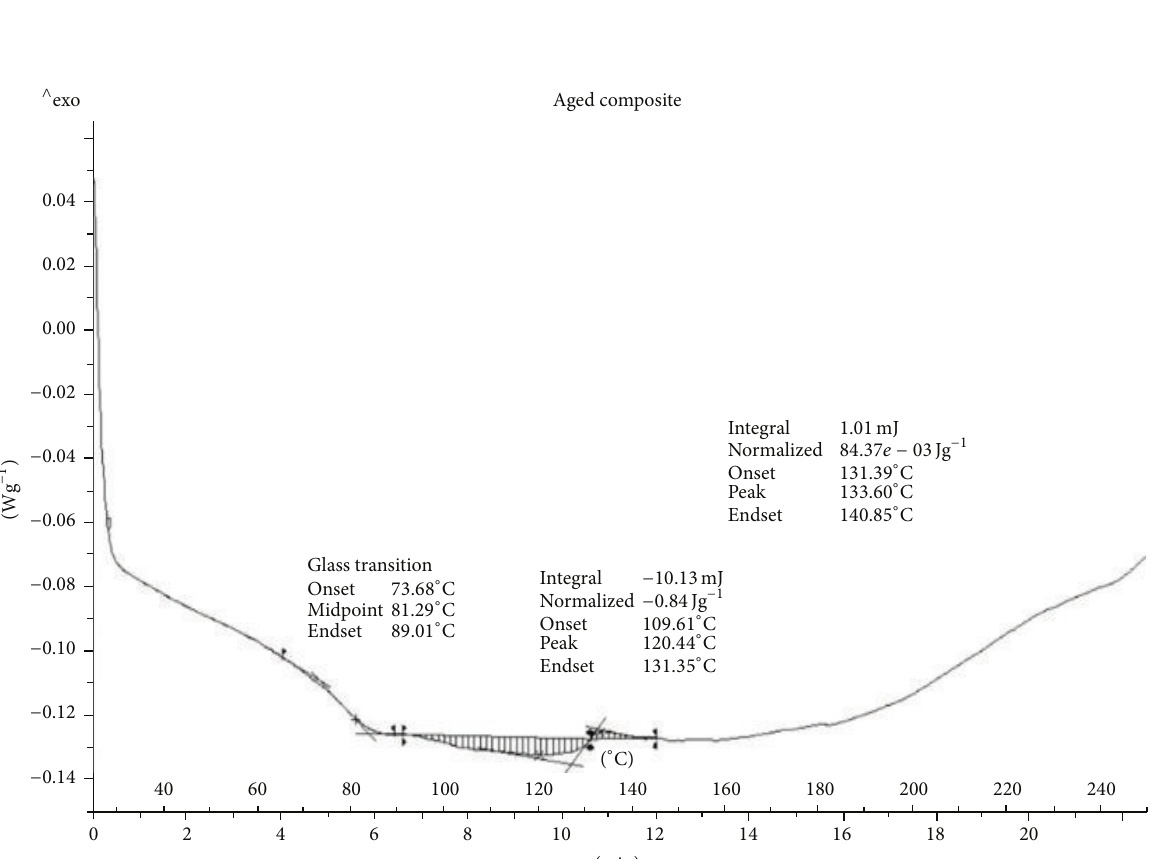
Figure 17: DSC curve of the unaged prepreg specimen.